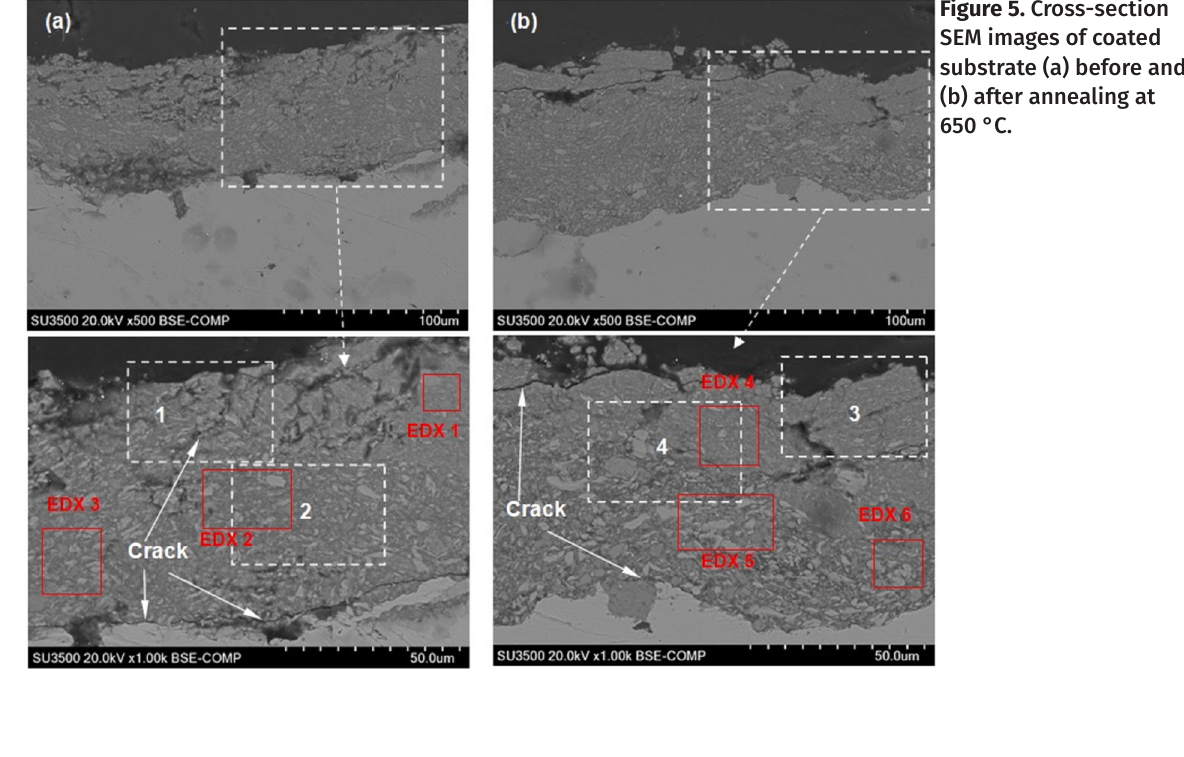
Figure 6. EDX elemental mapping of coated substrate (a) before and (b) after annealing at 650